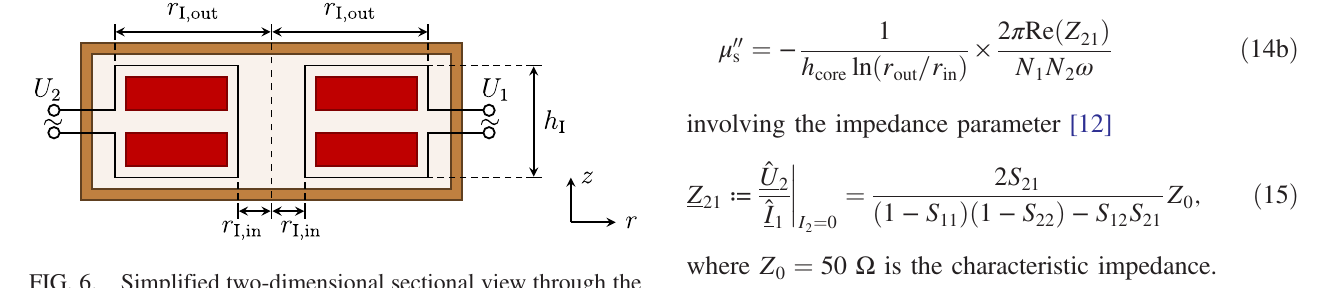
FIG. 6. Simplified two-dimensional sectional view through the center of the cavity to illustrate geometric quantities related to the location of the primary and secondary winding. The values of the quantities are given in Table III.